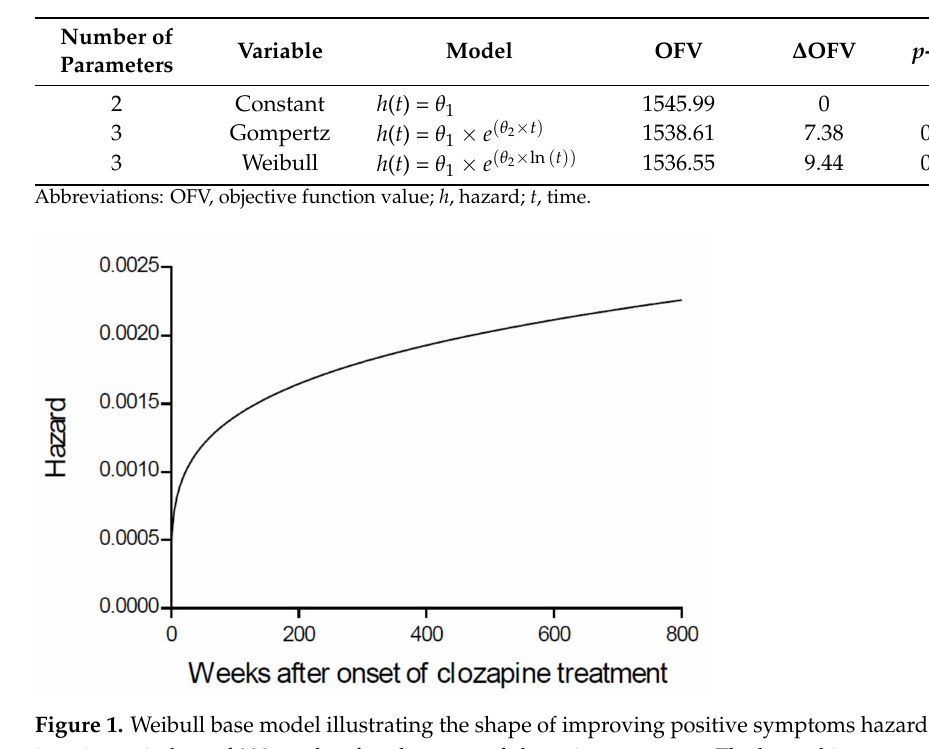
Table 2. Objective function value and the number of parameters in different tested survival models.